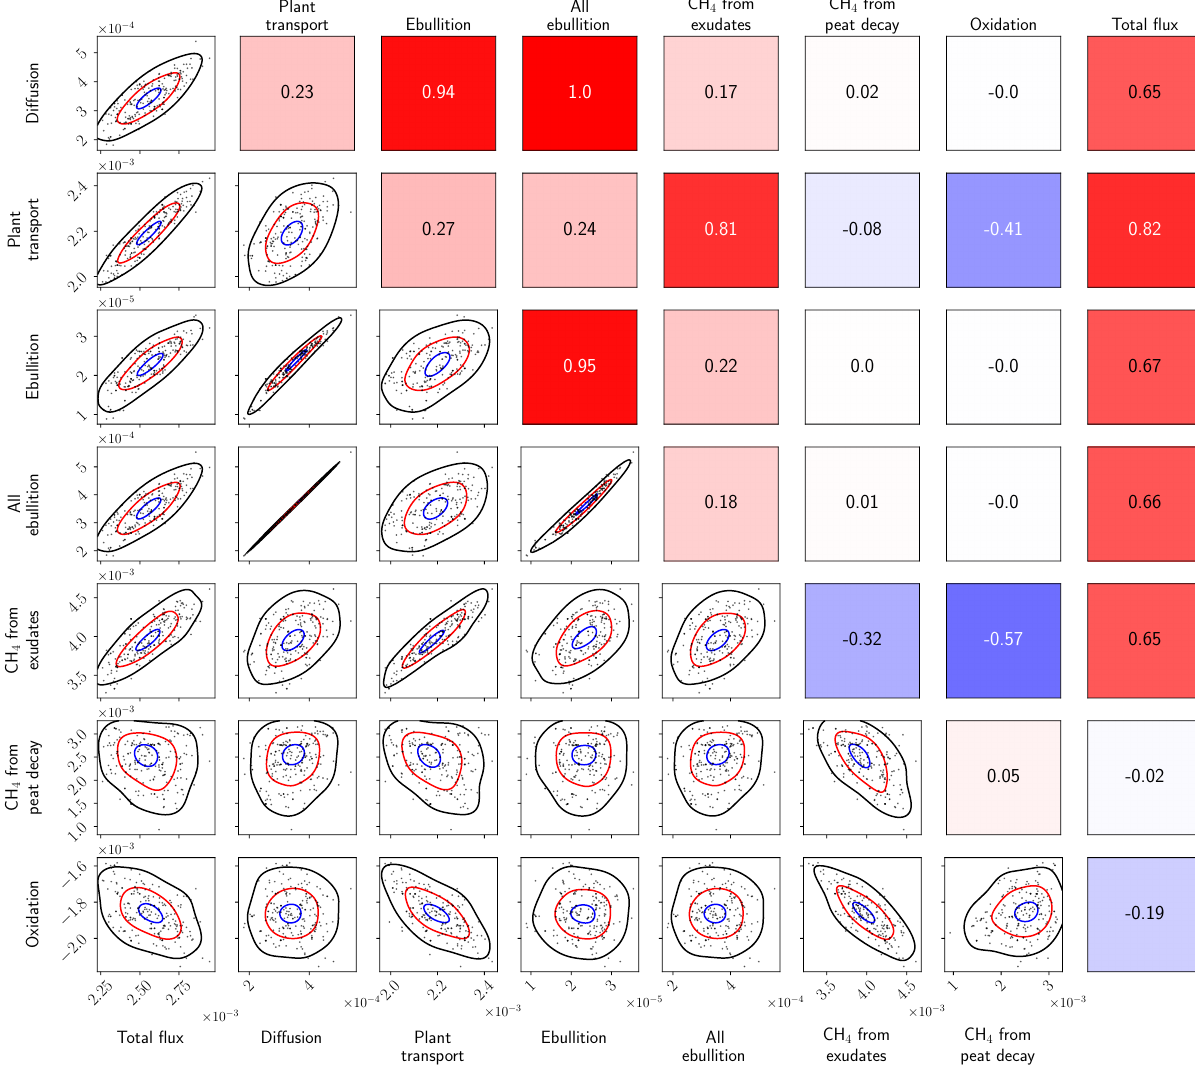
Figure 5. Posterior distributions and correlations of the annual means of the output from the modeled processes for the year 2012. The dynamics for the other years are mostly similar, but the strengths of the correlations vary somewhat. The results shown are based on 1000 random samples from the parameter posterior distribution. The two-dimensional marginal distributions in the triangle on the lower left have their labels on the left and at the bottom, and the correlations between the processes in the upper triangle on the right have their labels on the left and at the top. The images in the lower left triangle show the 90% (black), 50% (red), and 10% (blue) contours. The all-ebullition and diffusion fluxes correlate almost fully, showing that the “diffusion” flux has a strong contribution from underground